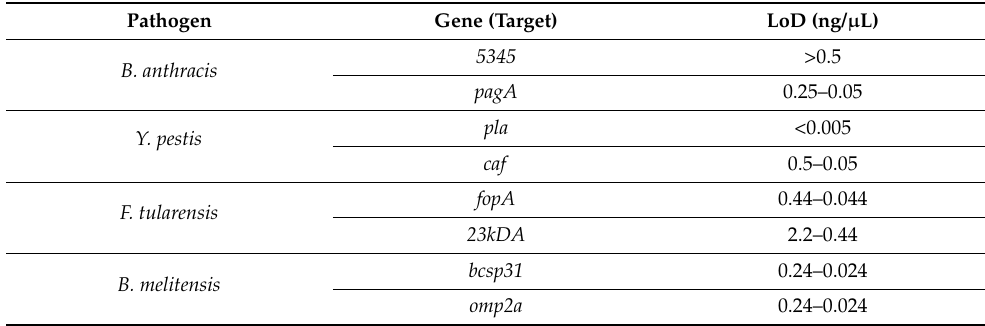
Table 3. Measured limit of detection (LoD) values for the MOL-PCR method using established detection panel for the biothreat